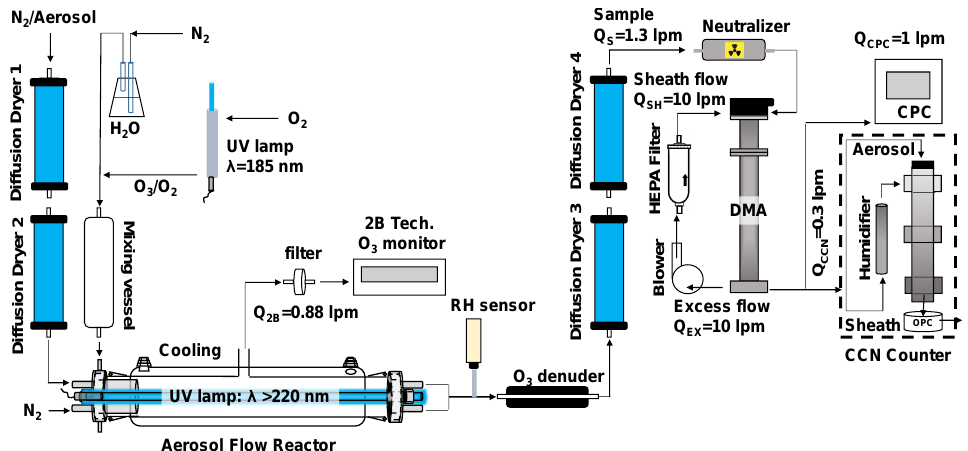
Figure 1. Schematic illustration of the experimental setup to examine the effect of OH and O 3 oxidation on the CCN activity of single- component and multicomponent biomass burning aerosol surrogate particles. From top left to bottom right: aerosol generation and drying stage, O 3 production and humidification (mixing vessel), the aerosol flow reactor, O 3 -free ultraviolet lamp and O 3 monitor, relative humidity probe (RH sensor), O 3 denuder, second drying stages, aerosol sizing by the DMA and particle counting by the CPC, and determination of the CCN activity by the